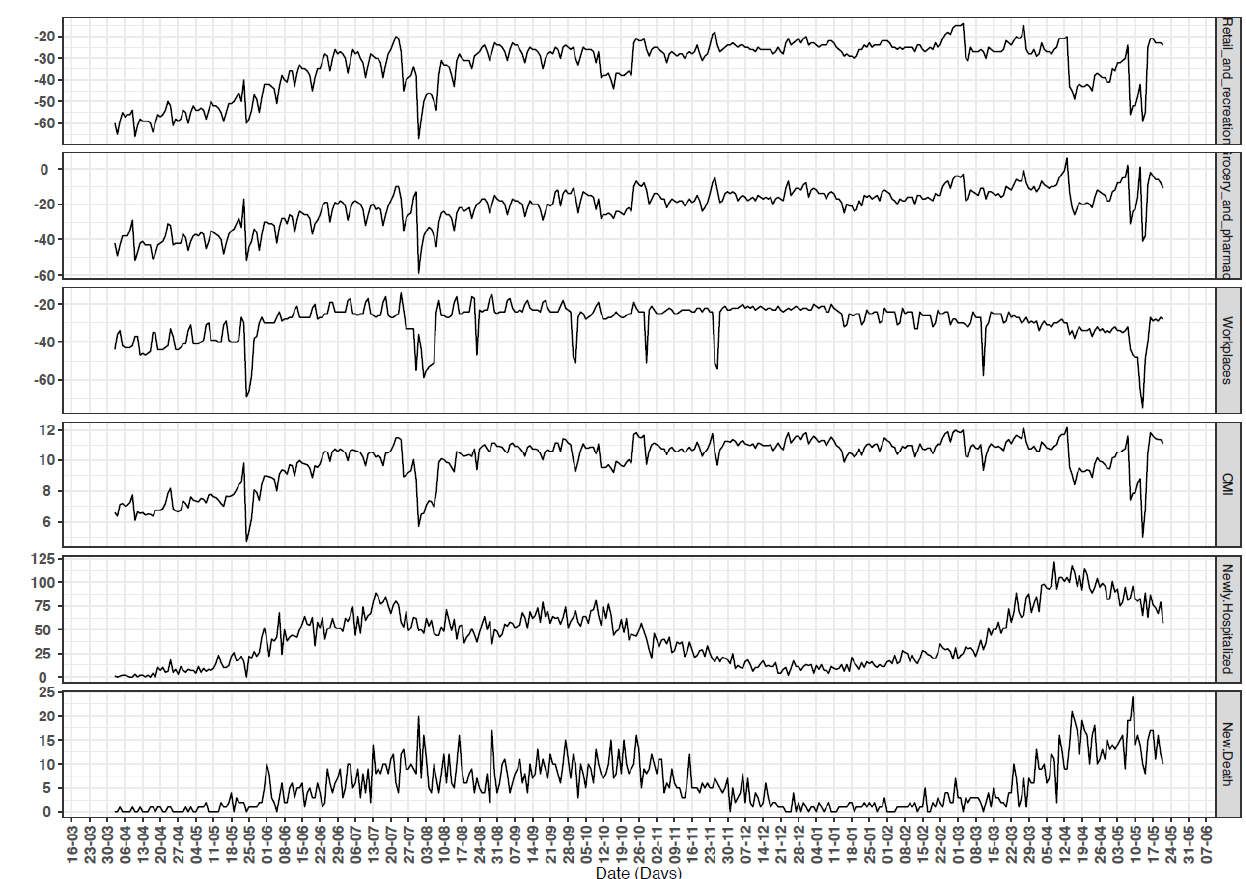
Figure 1. Time series of the studied community mobility reports (CMRs), community mobility index (CMI), hospitalisation and deaths from COVID-19, Oman, 1 April 2020 to 22 May 2021.